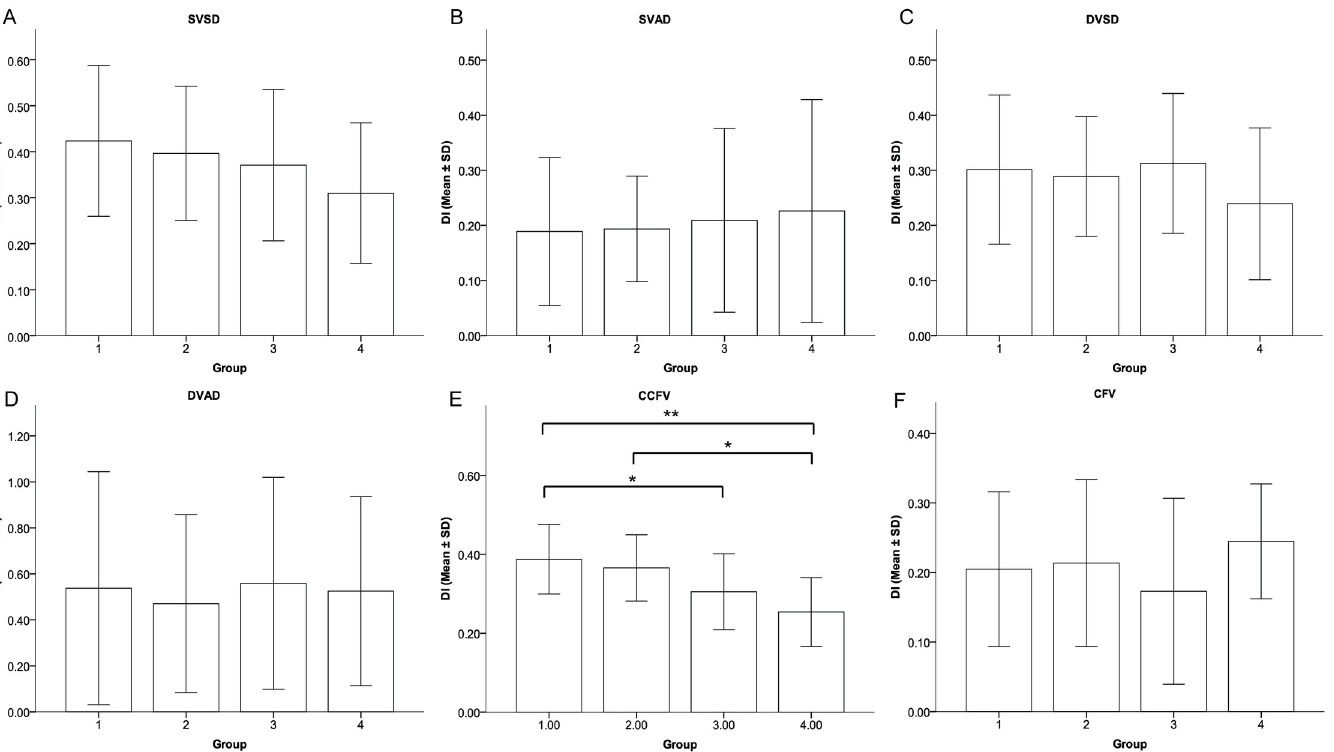
Fig 4. Comparison of DIs for all OCTA parameters between diabetic retinopathy severity groups. A, B, C, D, F: there was no statistically significant difference between the groups. E: the DI of the CCFV in Group 4 was significantly smaller than in Groups 1 and 2, and the DI in Group 3 was significantly smaller than in Group 1. � P < 0.05 and �� P < 0.001. Group 1: nondiabetic controls; Group 2: diabetes without DR; Group 3: mild NPDR; Group 4: severe NPDR and PDR. Bars represent means, and whiskers represent standard deviations.